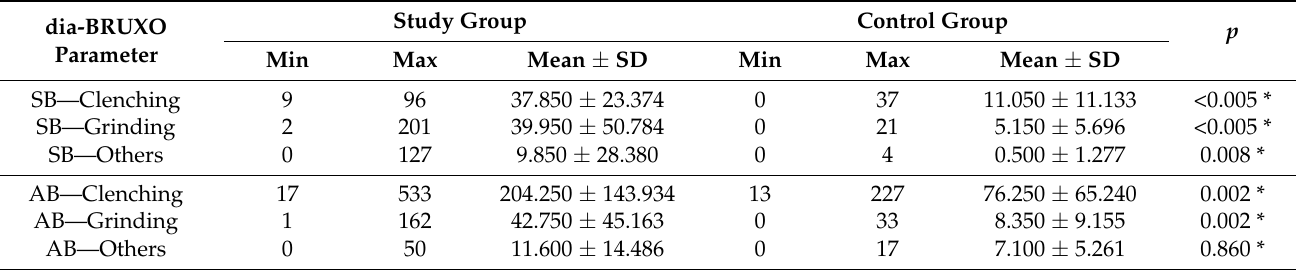
Table 3. SB and AB events.